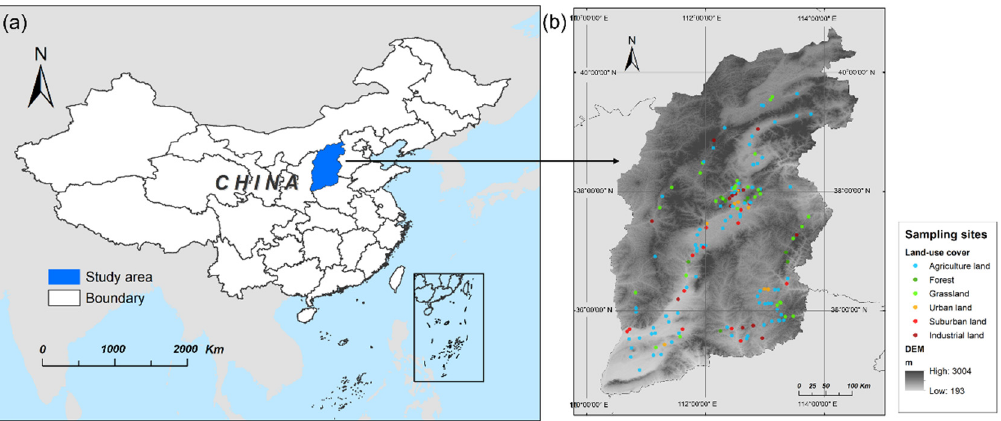
Figure 1. Location of ( a ) study area and ( b ) sampling sites under various land-use covers.